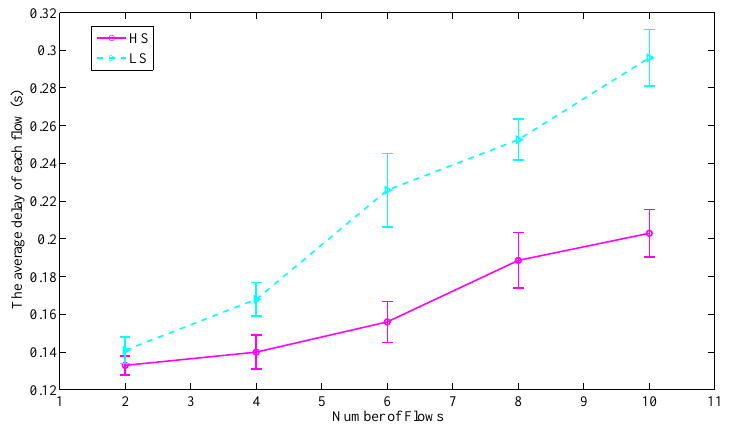
Figure 12. The delay comparison of different service priority information.